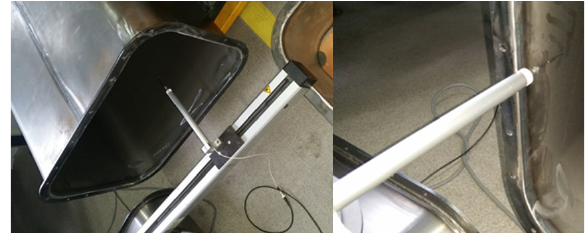
Fig. 7 Measurement of velocity distribution in duct